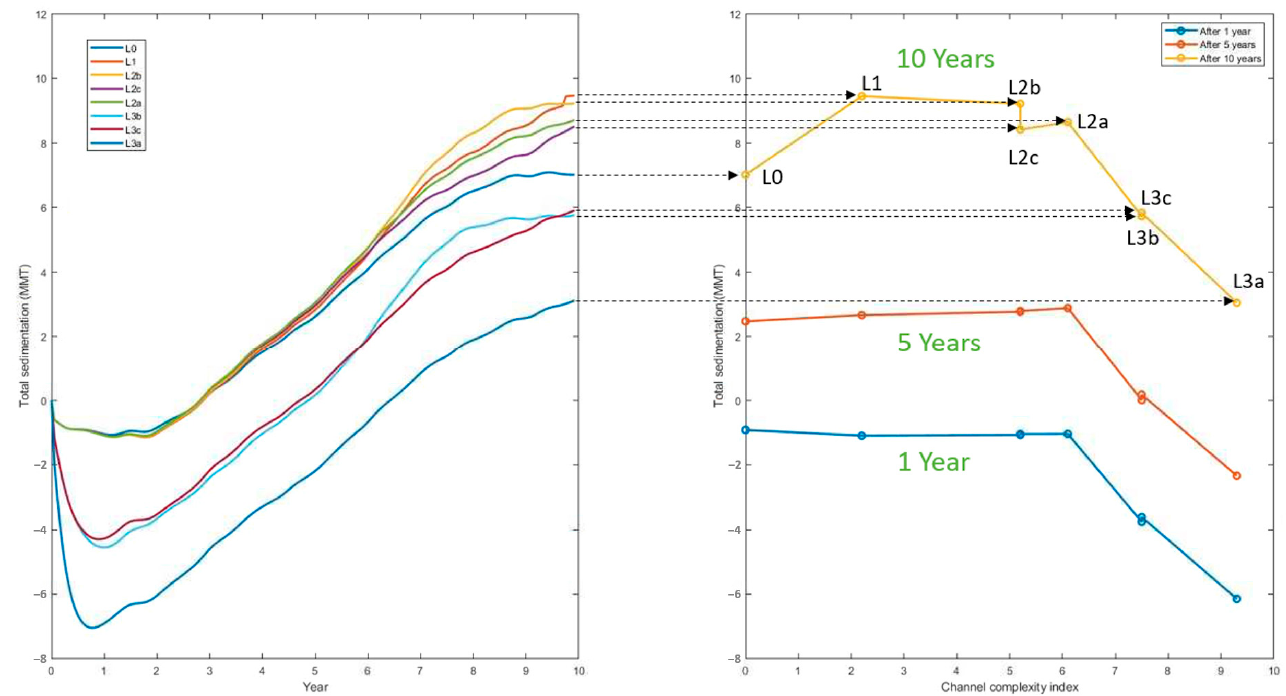
Figure 8. Time series of the total sedimentation (MMT) for each deltaic system (left subfigure), and the total sedimentation vs. channel complexity in Year 1, Year 5, and Year 10 (right subfigure).